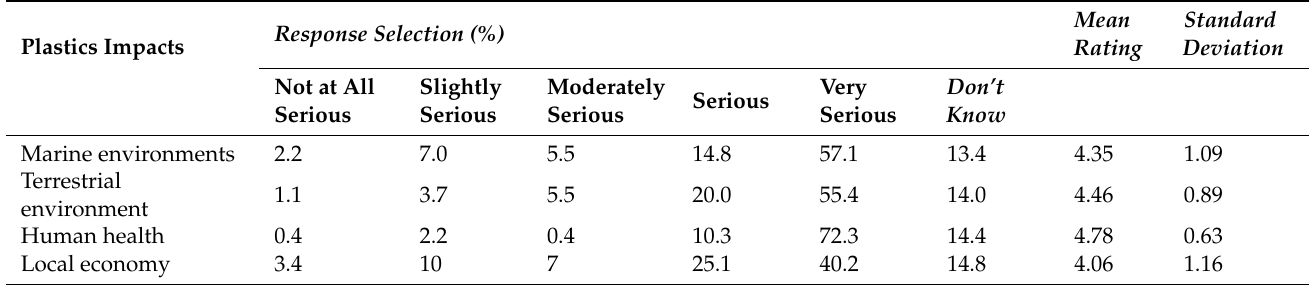
Table 4. Ratings on the seriousness of threats from the use of single-use plastics on the environment, human health and economy.